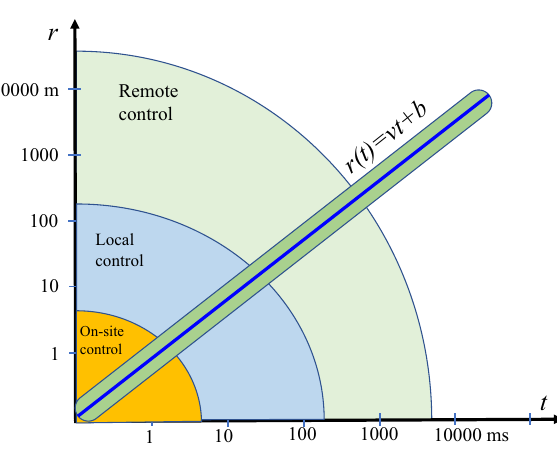
Figure 2. ICS functions distributed in